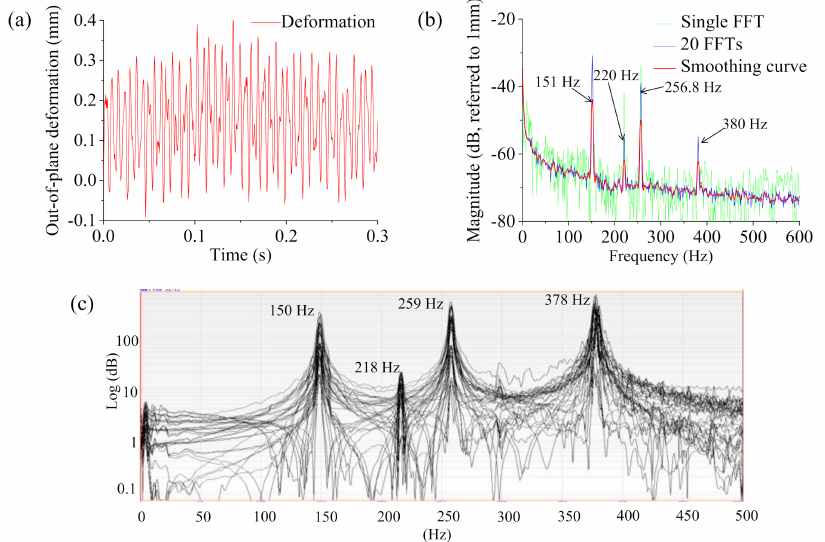
Figure 8. The response and spectral data of the load-carrying plate at a point near the corner: ( a ) time domain, ( b ) frequency domain using 3DPT, ( c ) frequency domain using an accelerometer and roving